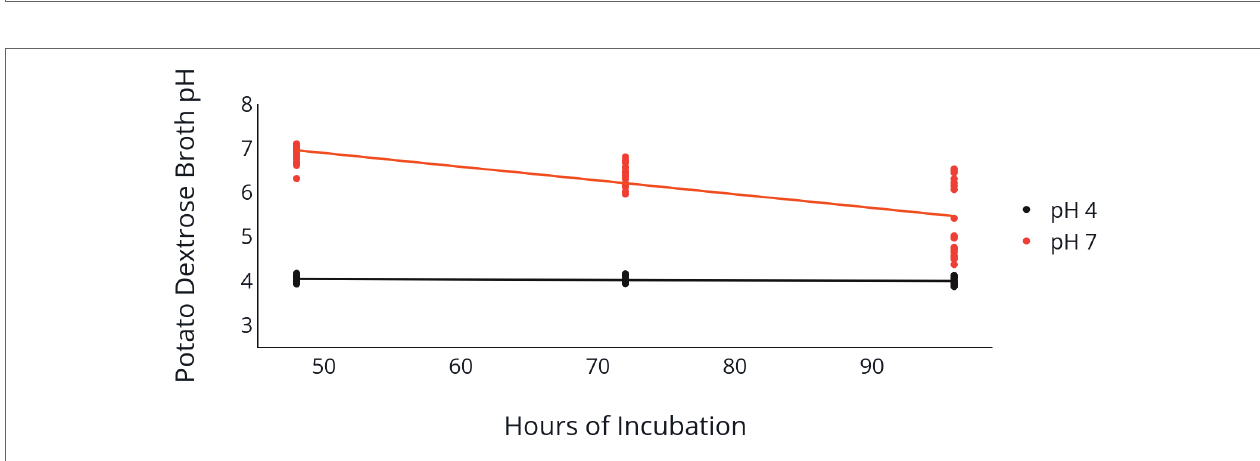
FIGURE 2 | OA production by C. jacksonii in response to medium pH. OA concentration in PDB following incubation of two C. jacksonii isolates for 96 h at an initial pH of 4 (black) or an initial pH of 7 (orange). The two isolates were tested in triplicate and the study was repeated three times for a total of 36 data points. No isolate or run differences were observed, so the results were combined. The middle line within the box indicates the median OA concentration value for each pH and the top and bottom lines of the box indicate the first and third quartiles, respectively.